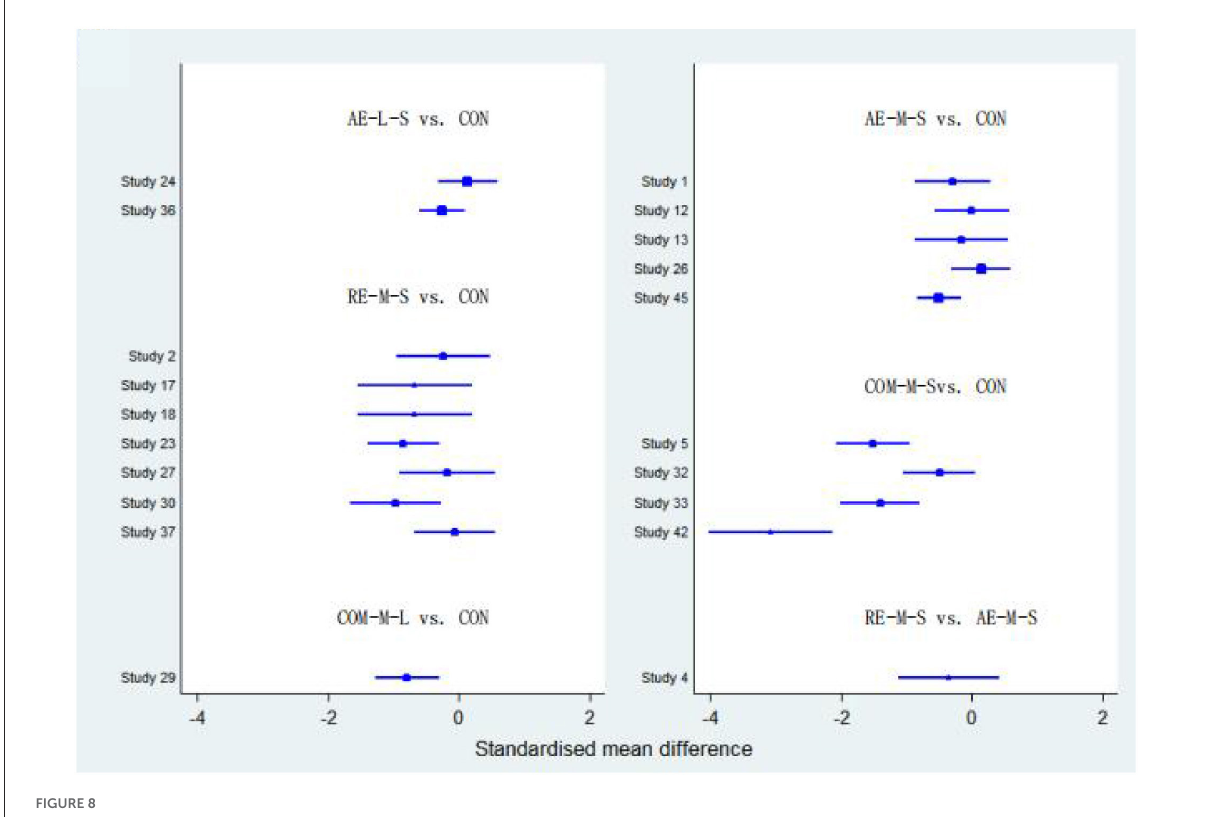
FIGURE8 The forest map for